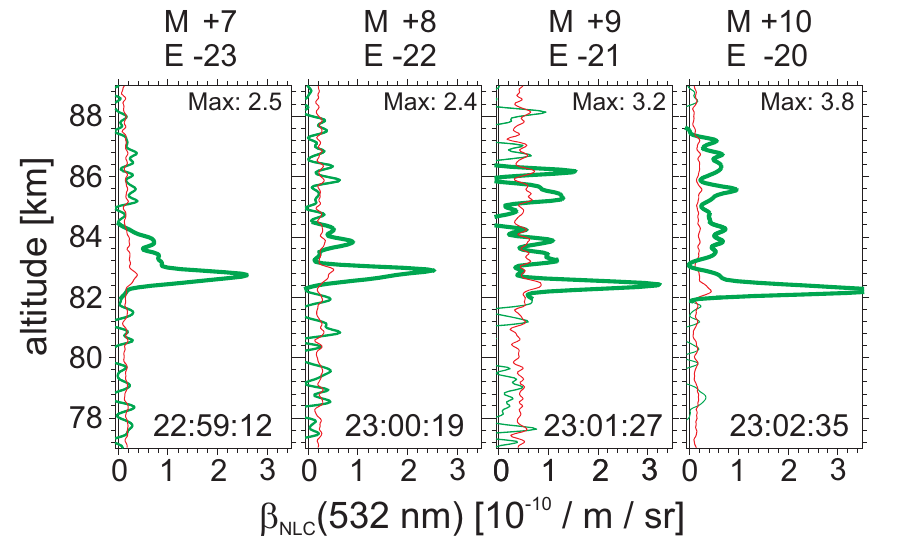
Fig. 6. Lidar backscatter ratio above ALOMAR shortly after the MASS1 and prior to the ECOMA3 launch. The time in minutes relative to the MASS and ECOMA 3 launch is indicated above the panels. Green lines show the measured backscatter coefficients, red lines are the error of the measurement calculated from the photon noise level. Thick green lines indicate the presence of